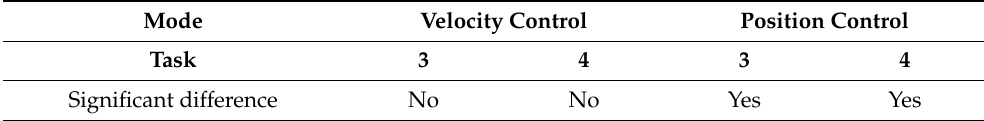
Table 3. Results of the statistical analysis of the two joints performance in tasks